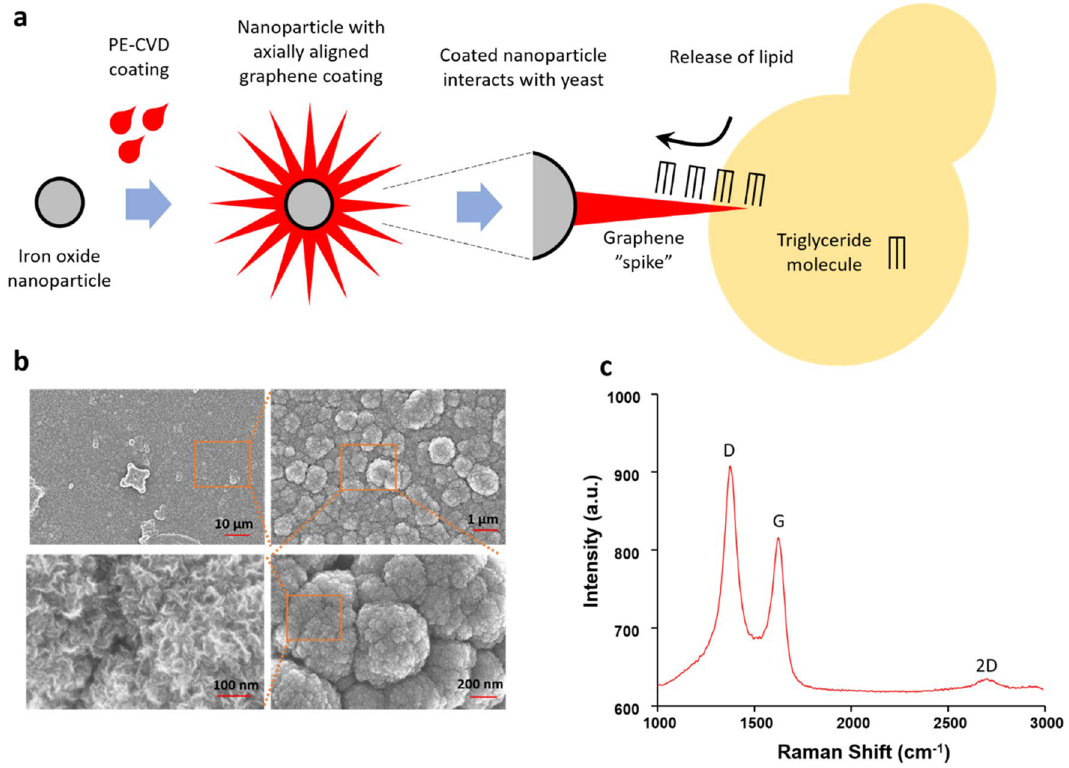
Figure 3. Characterization of iron oxide nanoparticles axially coated with PE-CVD graphene. ( a ) Overview of the coating procedure and lipid extraction strategy (prepared using Microsoft PowerPoint). Iron oxide nanoparticles were axially coated with PE-CVD graphene. Graphene spikes, in interaction with yeast cell, are expected to provoke extraction of lipids. In this schematic overview all constituents are not drawn to scale. ( b ) SEM images showing orientation and density of axial graphene coatings. Red lines indicate different levels of magnification. ( c ) Raman spectra (laser wavelength of 638 nm) of axial graphene coatings on iron oxide nanoparticles. The three main peaks characteristic for Raman spectra of graphene are marked: D, G, and